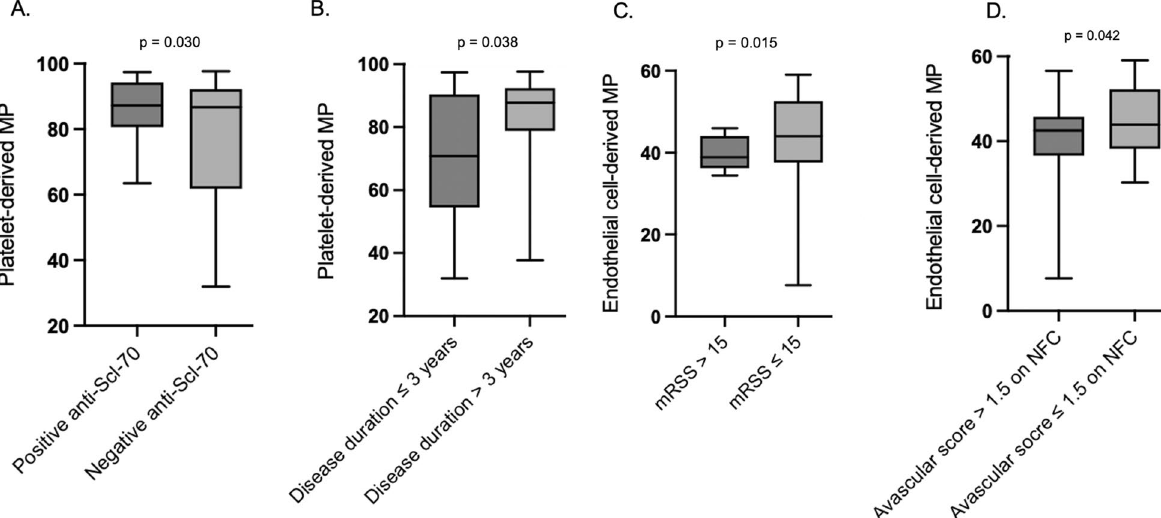
Fig. 3 Associations found between microparticles (MP) and clinical features of systemic sclerosis (SSc). A Percentage of platelet-derived MP in SSc patients according to the presence of anti-Scl-70. B Percentage of platelet-derived MP in SSc patients according to disease duration. C Percentage of endothelial cell-derived MP in SSc patients according to modified Rodnan skin score (mRSS). D Percentage of endothelial cell-derived MP in SSc patients according to capillary loss on nailfold capillaroscopy